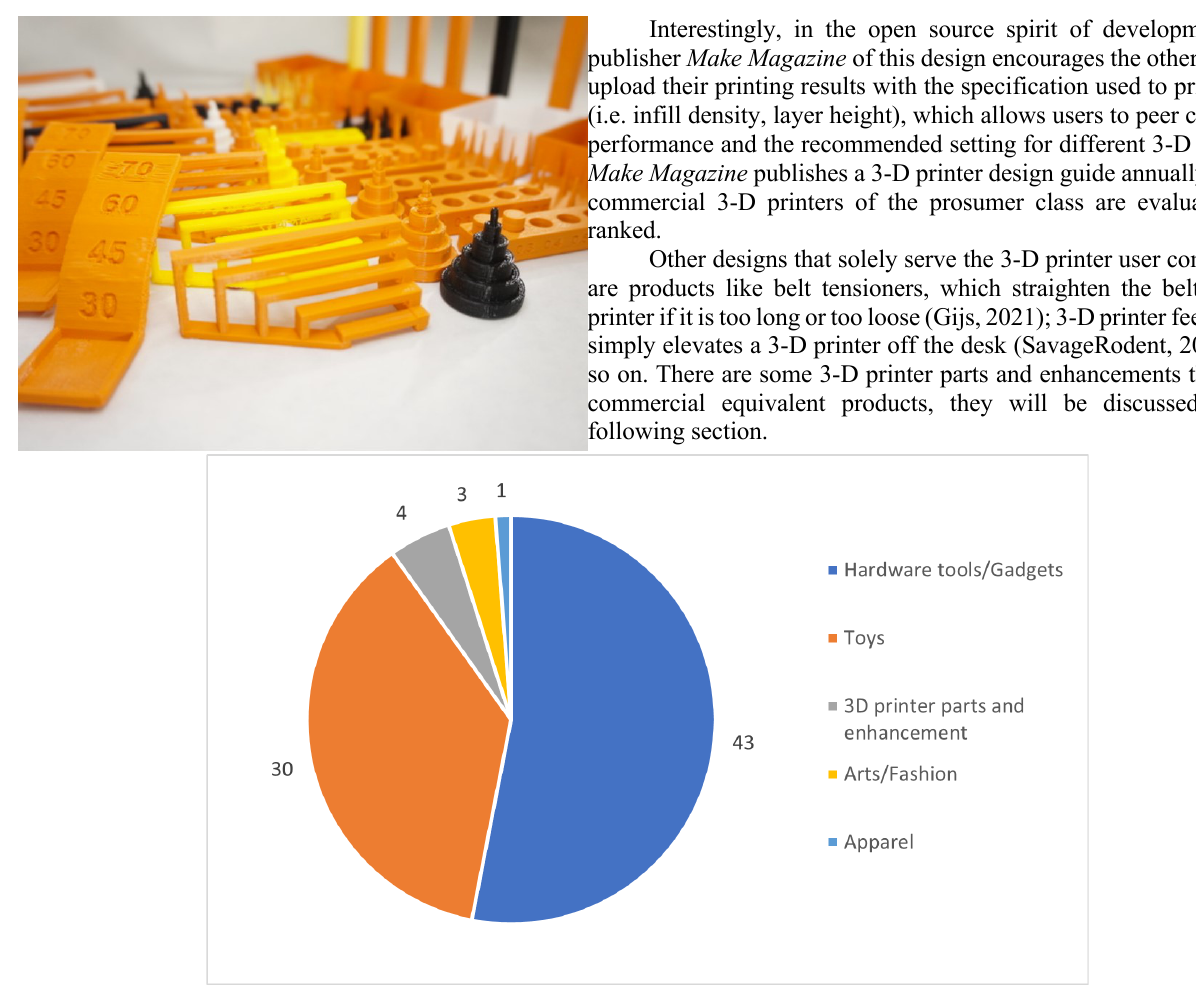
Figure 4: Subcategory for the money